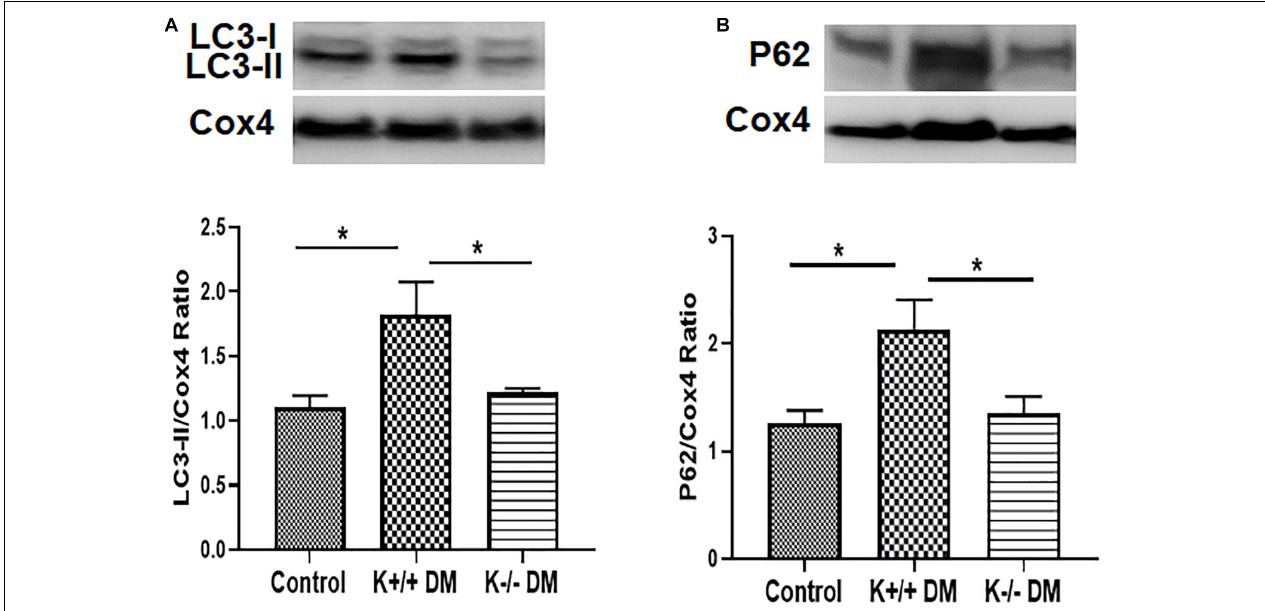
FIGURE 5 | KCa3.1 deficiency attenuated diabetes-induced inhibition of mitophagy in diabetic mice. The autophagy markers LC3 and P62 were assessed in mitochondria from diabetic kidney tissues using western blot analysis. Western blot analyses revealed an increased expression of LC3 (A) and P62 (B) in diabetic KCa3.1+/+ mice, which were significantly attenuated in KCa3.1 deficient mice (K − / − DM). Results are presented as mean + SEM. * P < 0.05, N = 5.